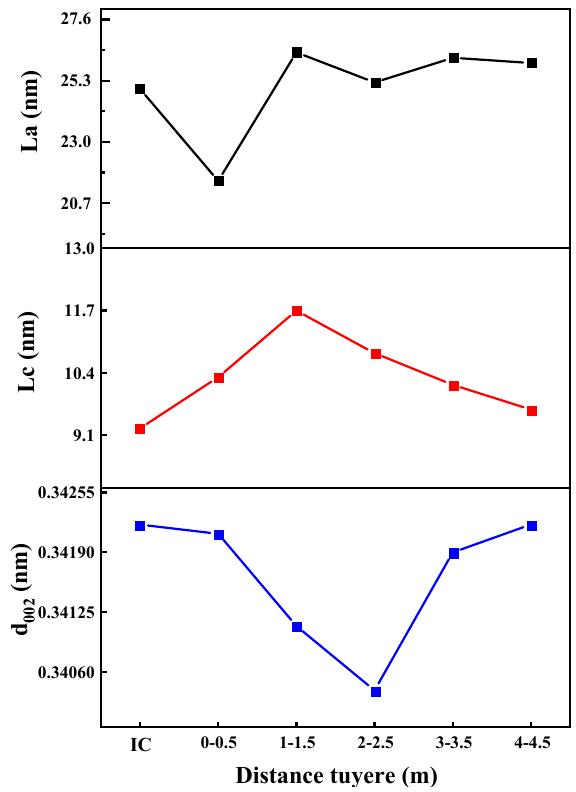
Figure 6. Variation trend of microcrystalline parameters of different radial coke.